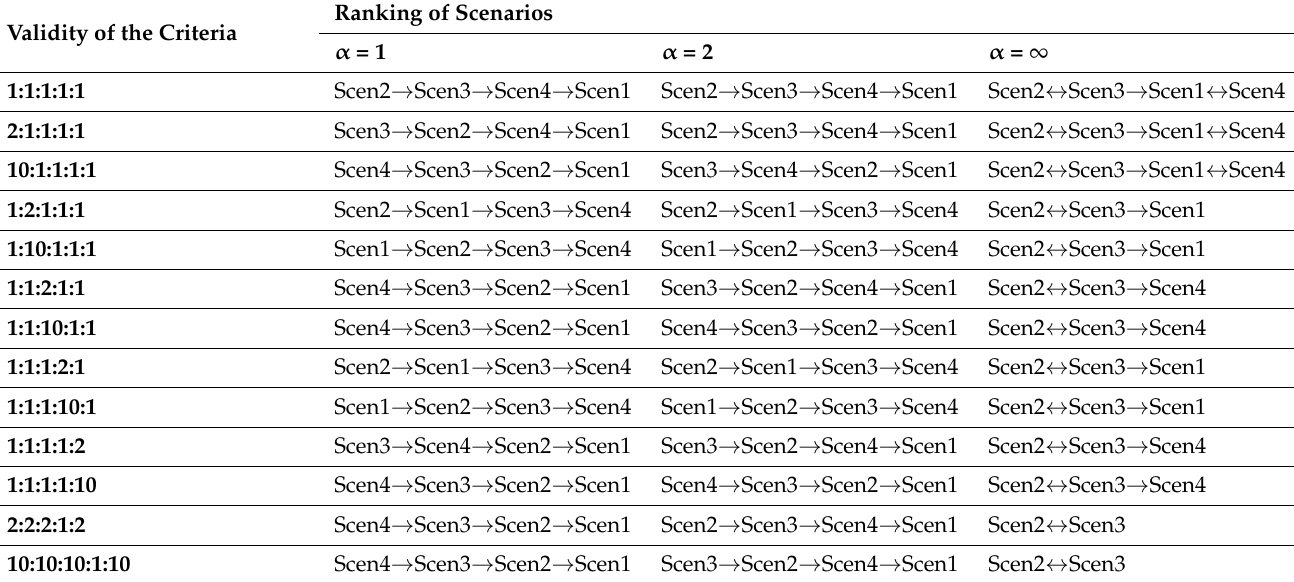
Table 3. Multi-criteria analysis results ranking maintenance and chloride removal